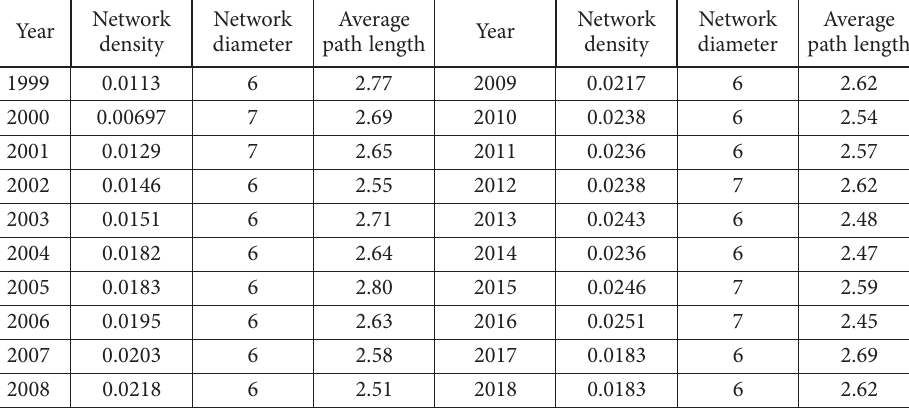
Table 1. 1999–2018 International coal trade indicators